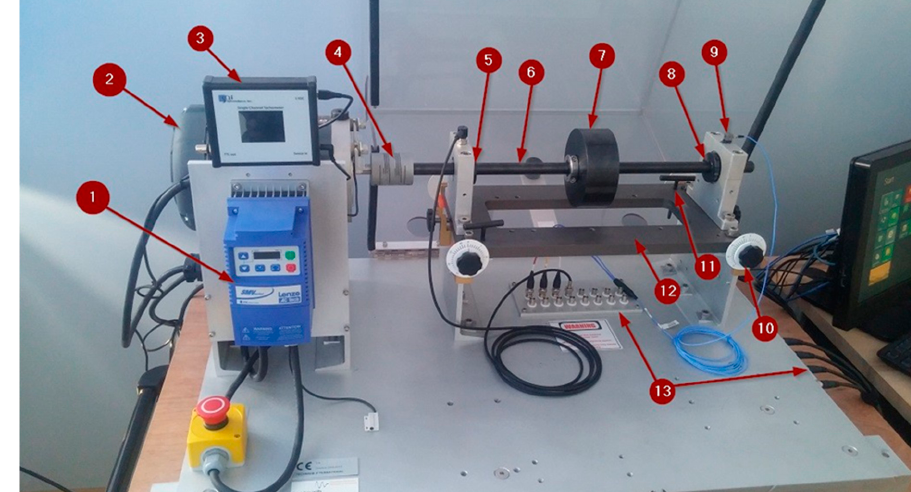
Figure 4. Fault simulator. (1) Frequency drive Lenze SMVector; (2) motor; (3) tachometer display; (4) clutch; (5) front-end bearing; (6) main shaft; (7) load; (8) back-end bearing; (9) three-axis IEPE accelerometer; (10) horizontal axis alignment screw; (11) vertical axis alignment screw; (12) base; (13) BNC connectors. Table 1. Simulated fault conditions.